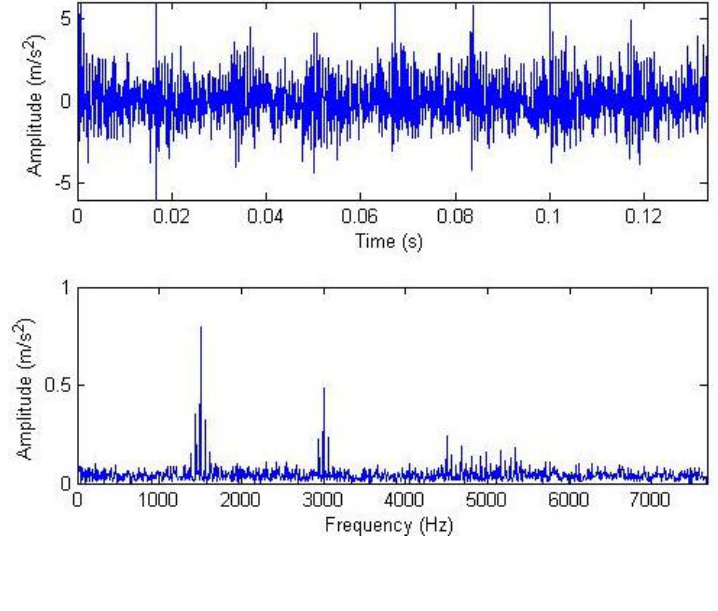
Figure 10. Waveform and frequency spectrum of primary signals